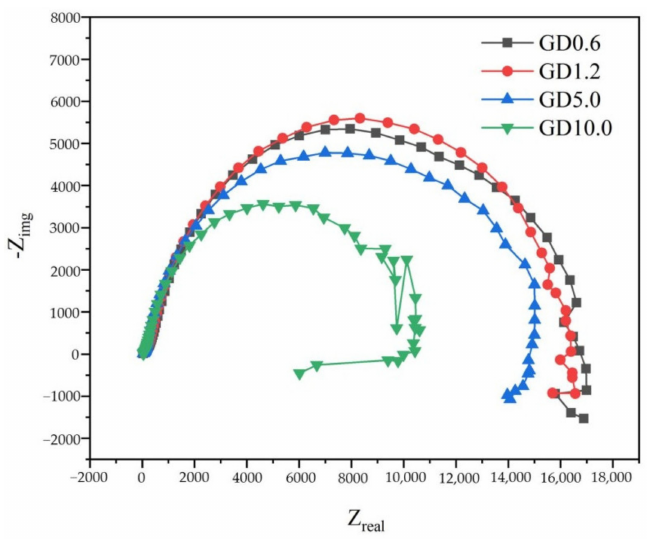
Figure 5. Nyquist plots of as-extruded Mg–Gd–Dy–Zr alloys in Hank’s